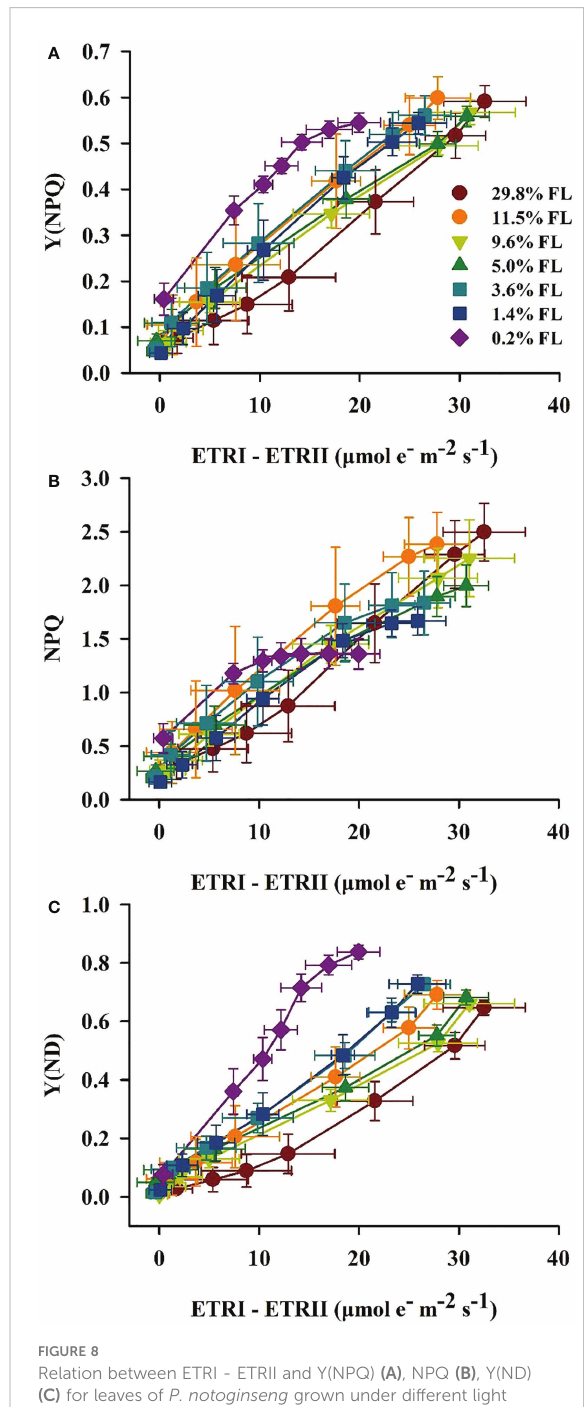
FIGURE 8 Relation between ETRI - ETRII and Y(NPQ) (A) , NPQ (B) , Y(ND) (C) for leaves of P. notoginseng grown under different light regimes. Values for each point were means ± SD ( n =